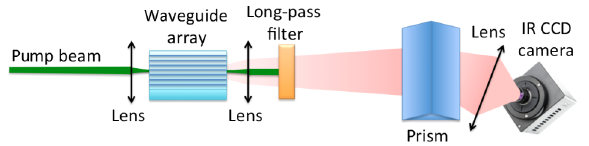
FIG. 4. Schematic illustration of the experimental setup of the spectral-spatial SPDC intensity-distribution measurements.